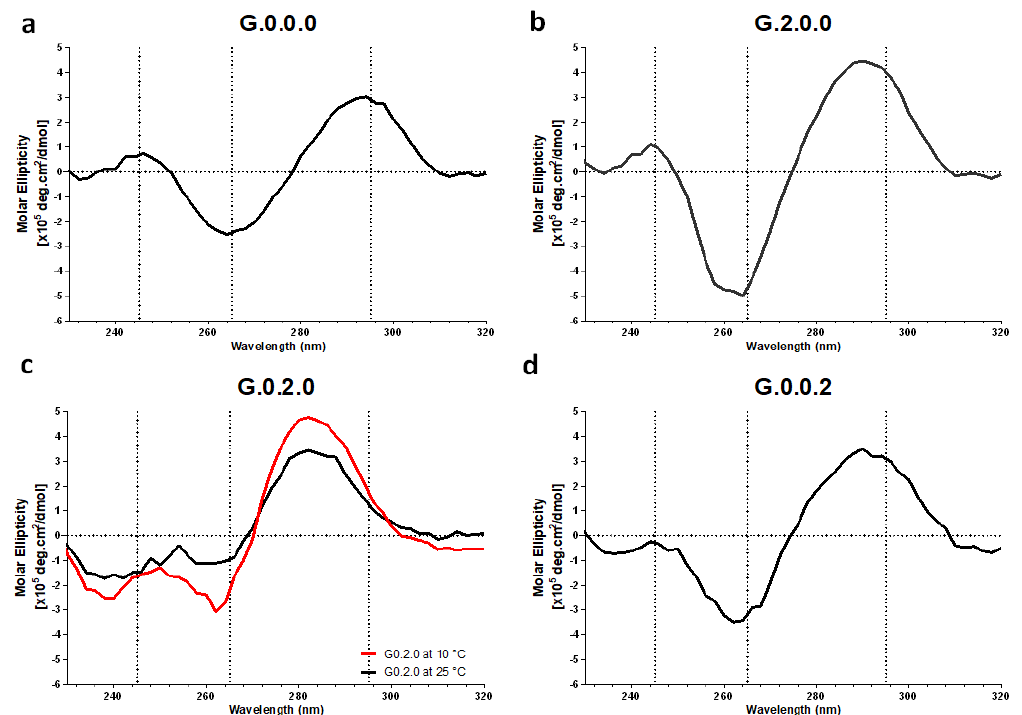
Figure 2. Circular dichroism spectra of ( a ) G0.0.0, ( b ) G2.0.0, ( c ) G0.2.0, and ( d ) G0.0.2 in D-PBS at 25 ◦ C (black line) or 10 ◦ C (red line). CpG ODNs concentration is 2 µ M.